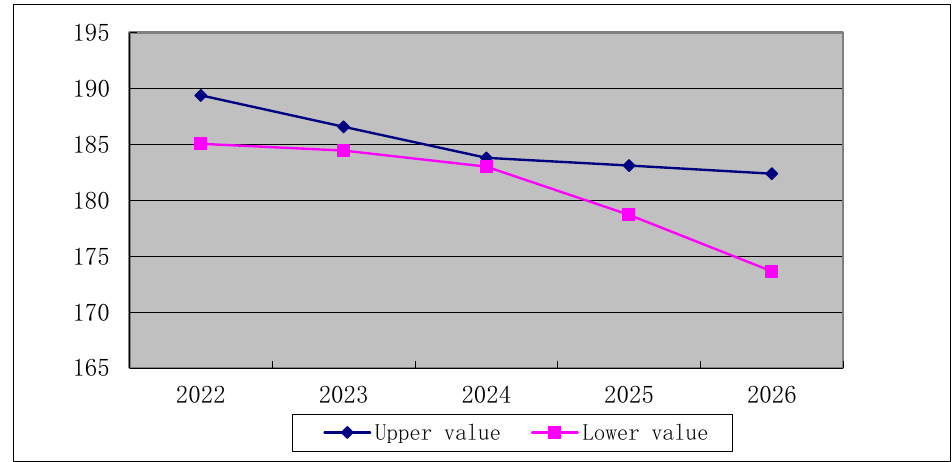
Figure 18. The variation interval of water requirement with the influence of the primary industry in Inner Mongolia.